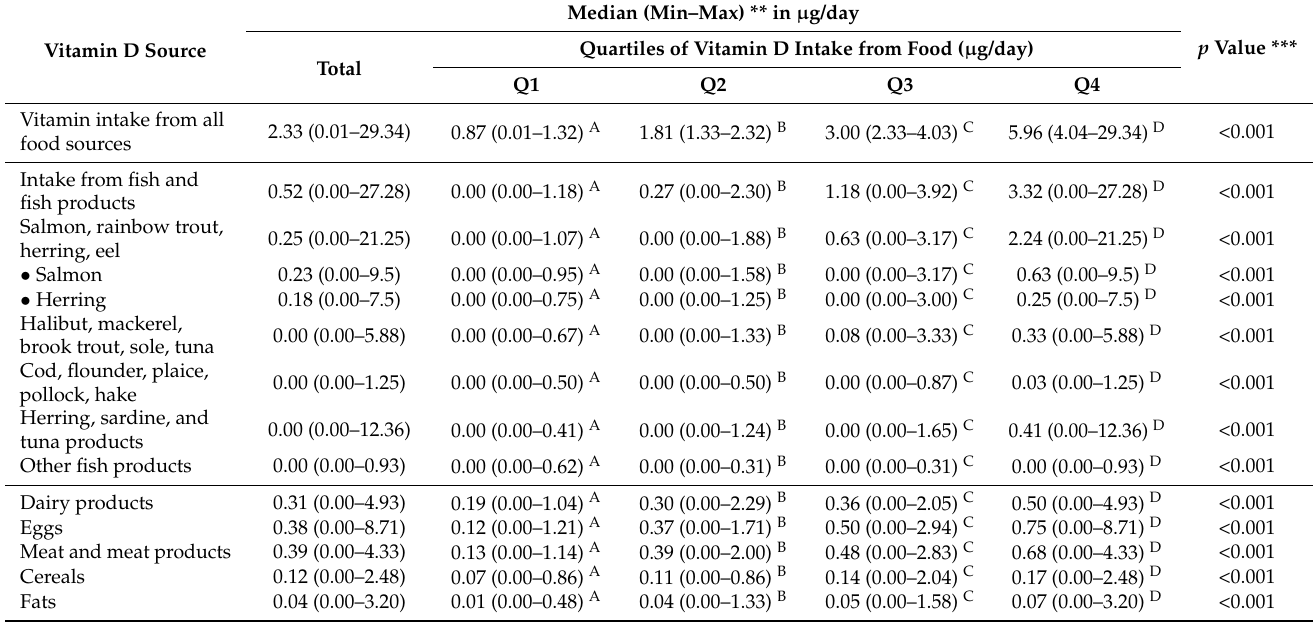
Table 2. Vitamin D intake from various food groups in the group of female post-primary school students (according to the quartiles of total vitamin D intake from